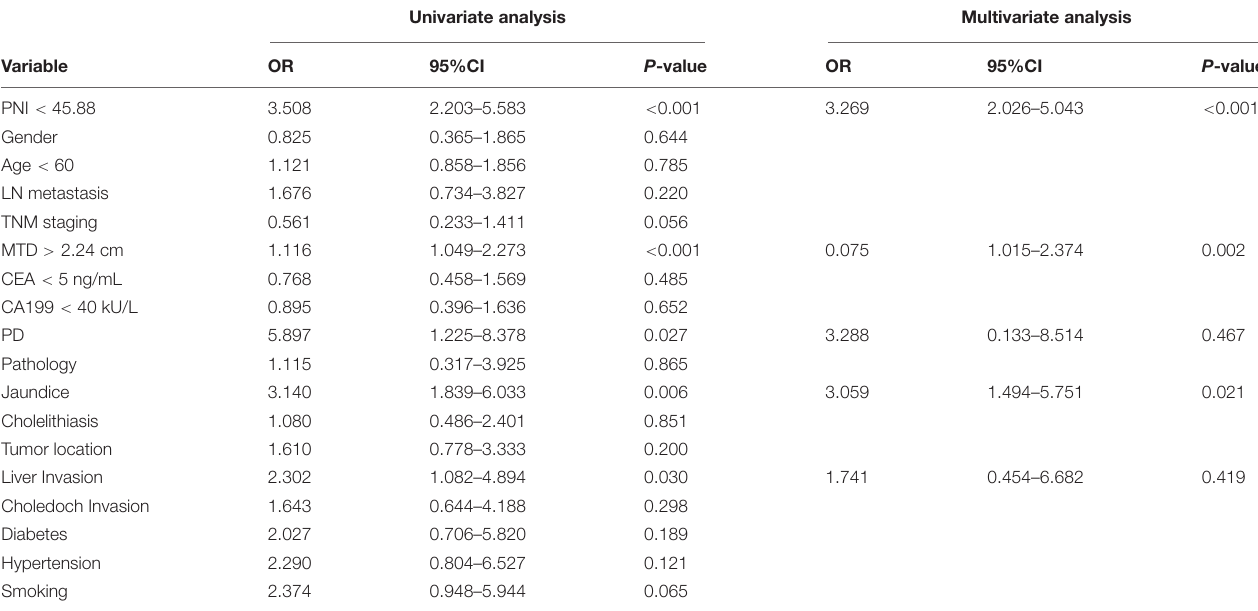
FIGURE 1 | The receiver operating characteristic (ROC) curve of poor prognosis established with the candidate factors of panel (A) prognostic nutrition index (PNI) and (B) maximum tumor diameter (MTD). TABLE 2 | Univariable and multivariate regression analyses of factors for the presence of poor prognosis in the primary cohort. Univariate analysis Multivariate analysis